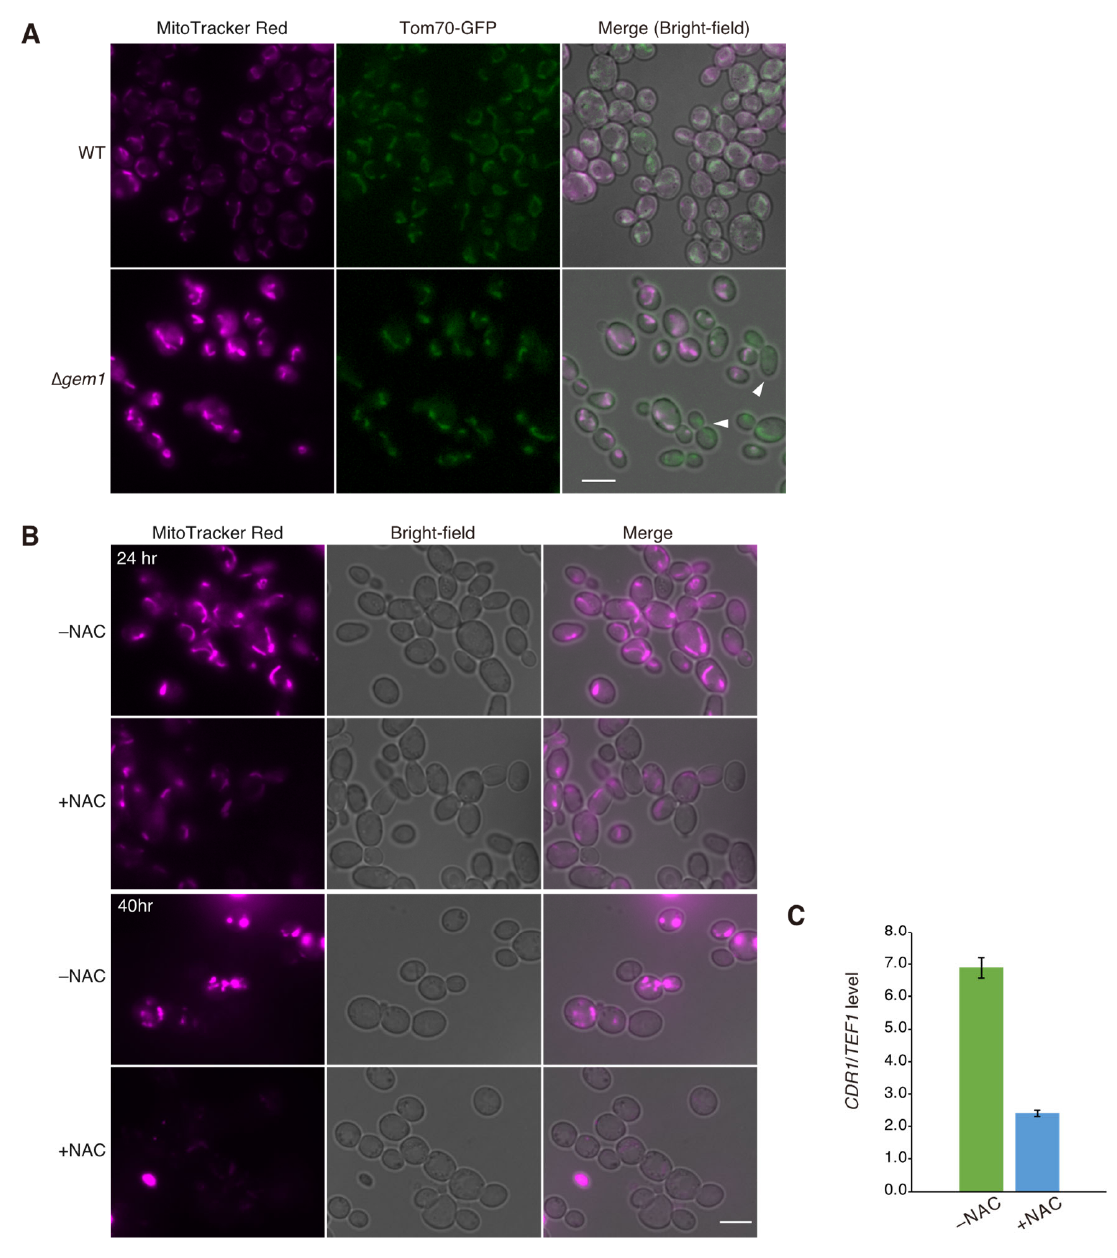
Figure 5. Mitochondrial ROS production in ∆ gem1 cells. ( A ) Detection of intracellular mitochondrial ROS (mtROS). Wild ‐ type and ∆ gem1 cells expressing Tom70 ‐ GFP were cultivated in minimal SD medium until the exponential growth phase at 30 °C. The cells were stained with MitoTracker Red CM ‐ H 2 XROS, washed, and observed using fluorescence microscopy. Tom70 was used as a mitochondrial marker. Arrowheads indicate cells in which mitochondria were present but not stained by MitoTracker Red CM ‐ H 2 XROS. ∆ gem1 cells contained approximately 29% cells ( n = 310) that were not stained by MitoTracker or weakly stained. Scale bar, 5 μ m. (B) Effect of N ‐ acetylcysteine (NAC) on ROS production in ∆ gem1 cells. ∆ gem1 cells were grown in SD medium with (+NAC) or without 10 mM NAC (–NAC) at 30° C for 24 or 40 h and then stained with MitoTracker Red. ( C ) Effect of NAC on CDR1 expression level in ∆ gem1 cells. ∆ gem1 cells were exponentially incubated in SD medium with (+NAC) or without 10 mM NAC (–NAC) at 30 °C for 40 h. CDR1 expression level was analyzed by quantitative RT ‐ PCR and normalized to the corresponding levels of the housekeeping transcript, TEF1 . Error bars represent standard errors of 3 independent experiments. The p ‐ value of the t ‐ test is less than 0.001.